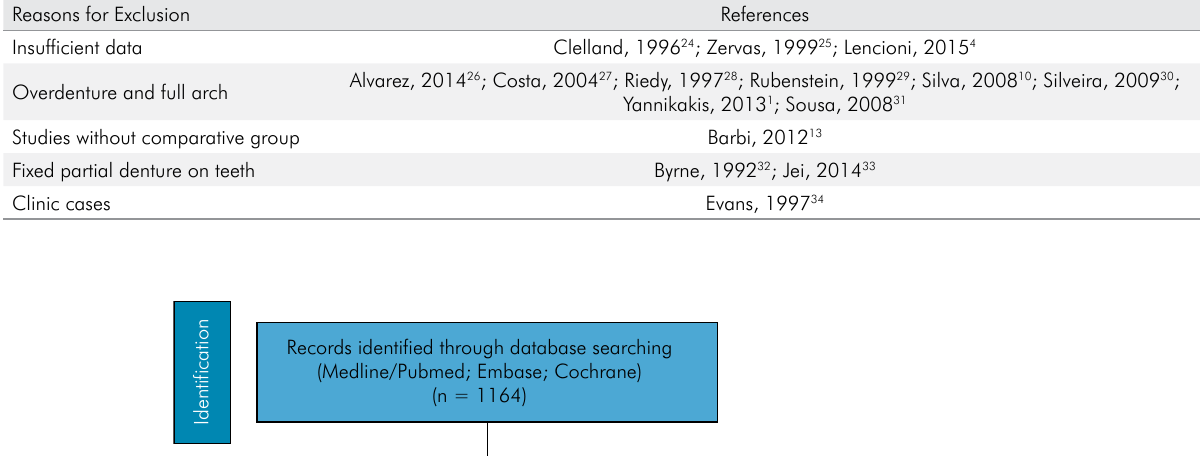
Table 1. Studies excluded and the reasons for exclusion.